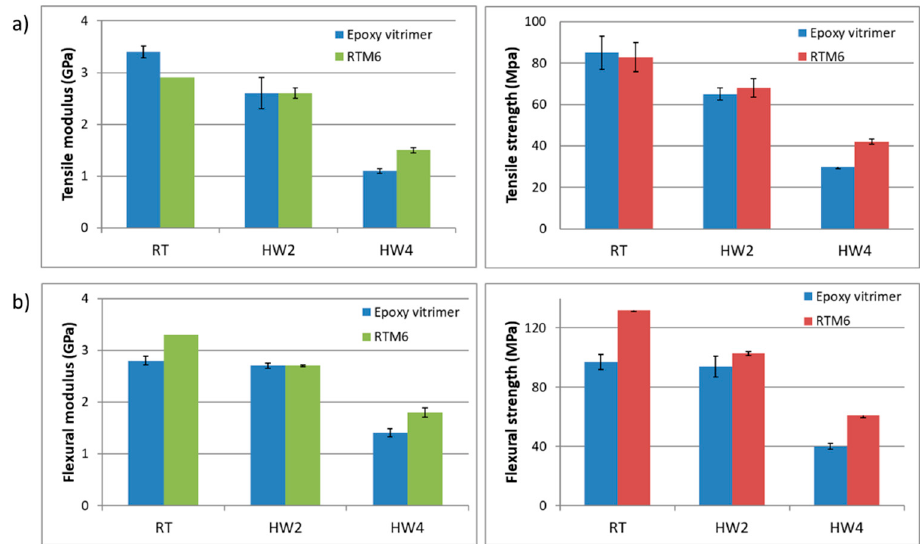
Figure 4 . ( a ) Tensile modulus and tensile strength of epoxy vitrimer and RTM6 formulations at RT, HW2, and HW4. ( b ) Flexural modulus and flexural strength of epoxy vitrimer and RTM6 formulations at RT, HW2, and HW4.